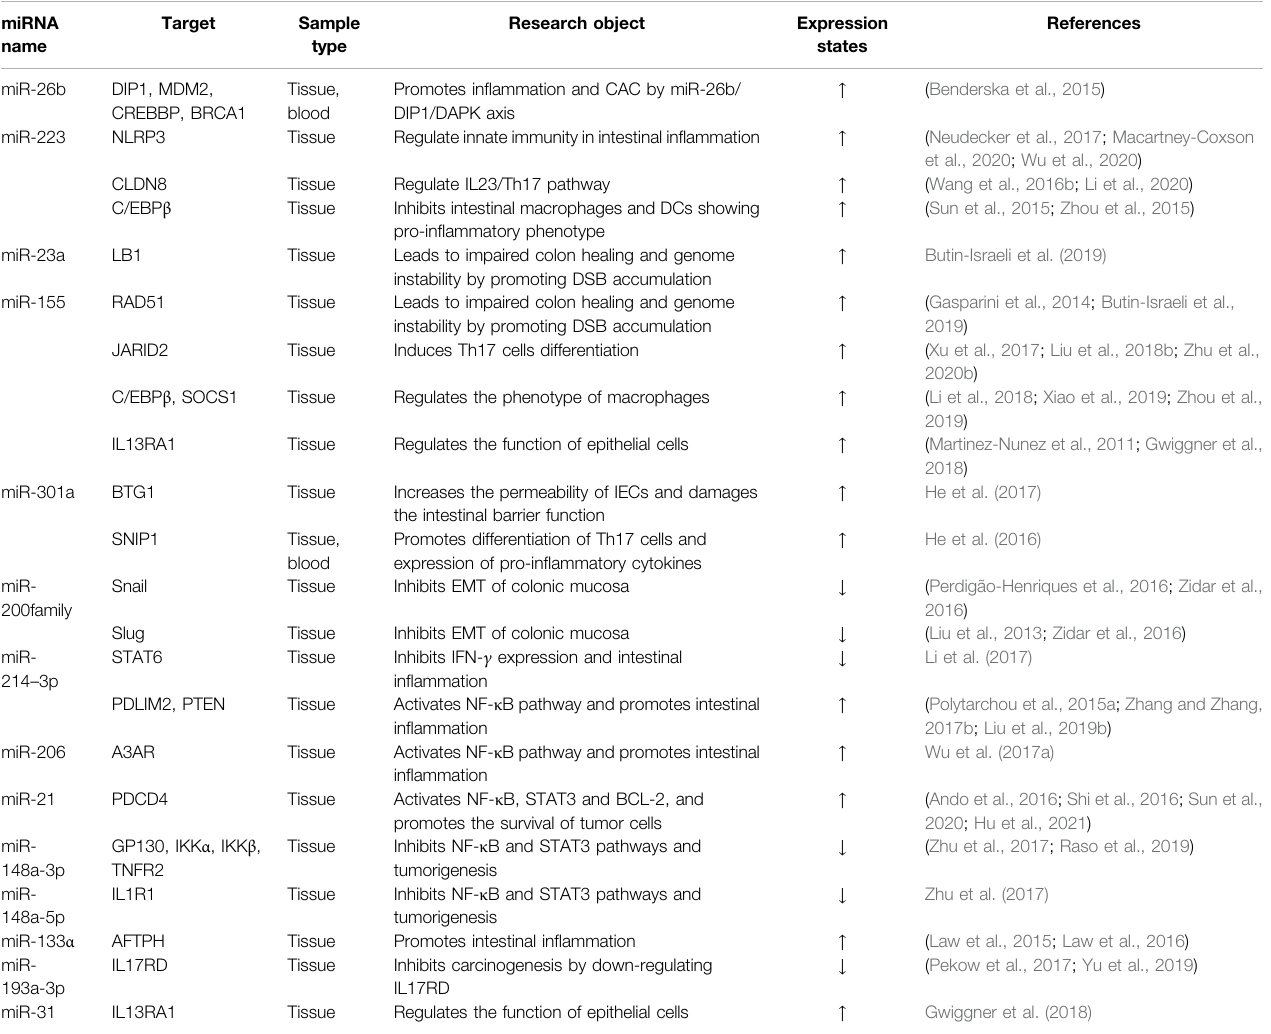
TABLE 2 | Differentially expressed miRNAs and its targets in UC. miRNA